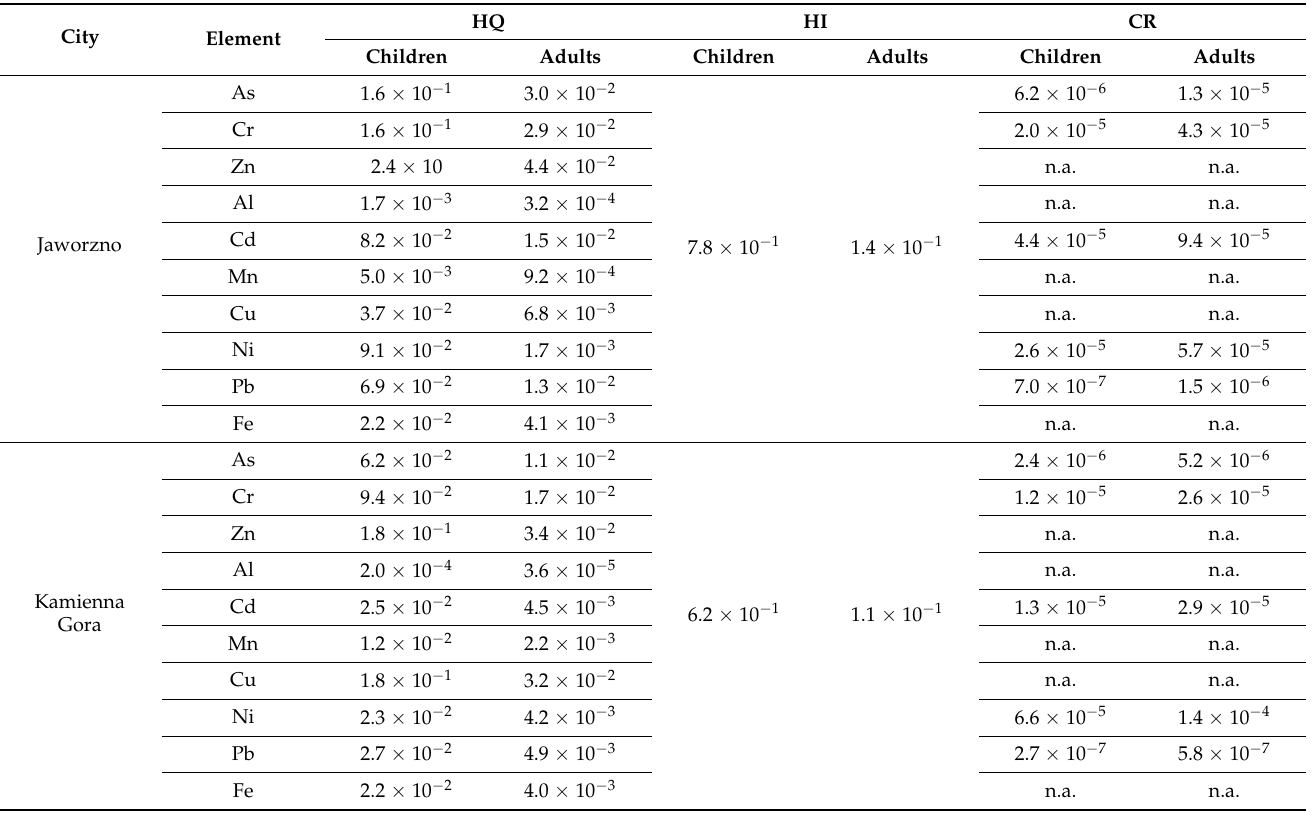
Table 8. HQ, HI and CR values in each city.